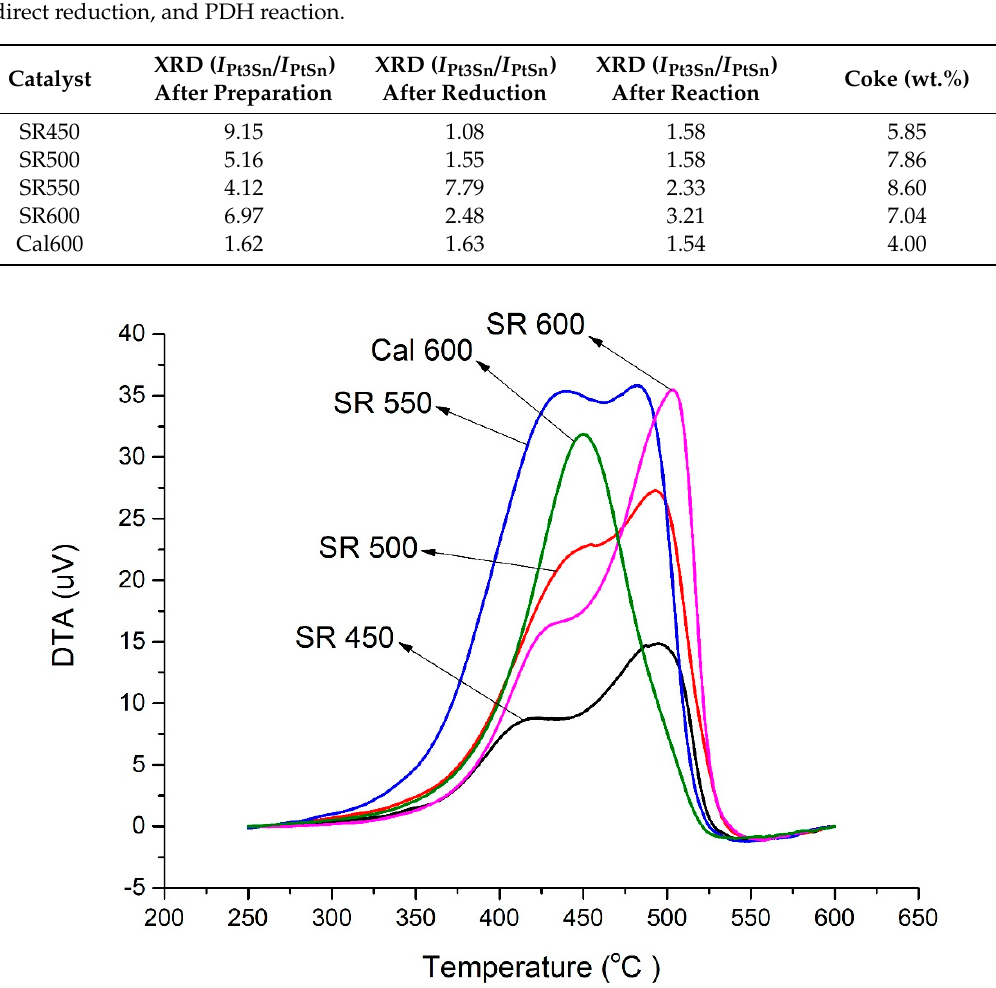
Figure 7. DTA curves of the Pt–Sn / Al 2 O 3 catalysts. Inflection points of SR450 were observed at 417.62 and 494.38 °C, SR500 = 454.29 and 492.97 °C, SR550 = 439.61 and 482.68 °C, SR600 = 429.71 and 503.27 °C, and Cal600 = 450.16 °C.